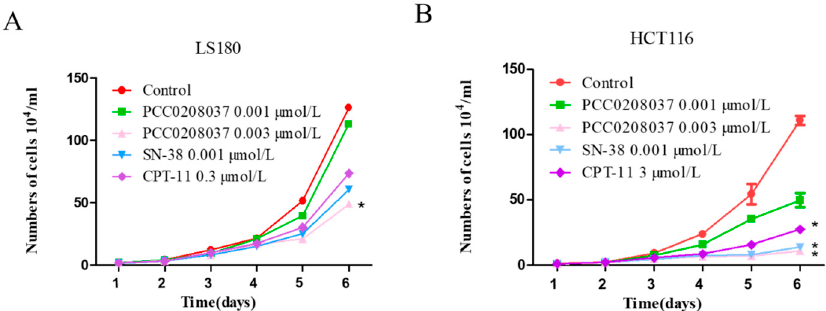
Figure 2. Effect of PCC0208037 on cell growth. ( A ) Cell growth curves of LS180 cells under different treatments. ( B ) Cell growth curves of HCT116 cells under different treatments. The data were expressed as the mean ± SD ( n = 3). * p < 0.05 as compared to the control.